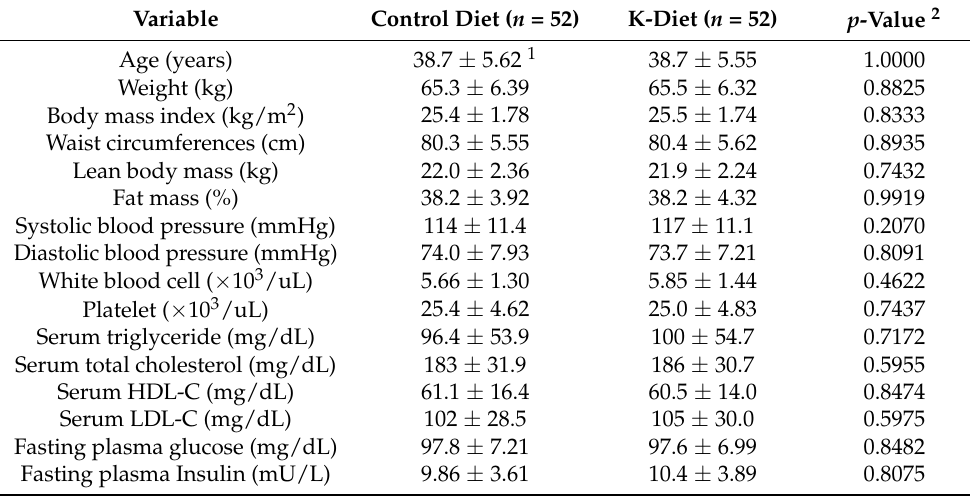
Table 1. Baseline characteristics in control diet and K-diet